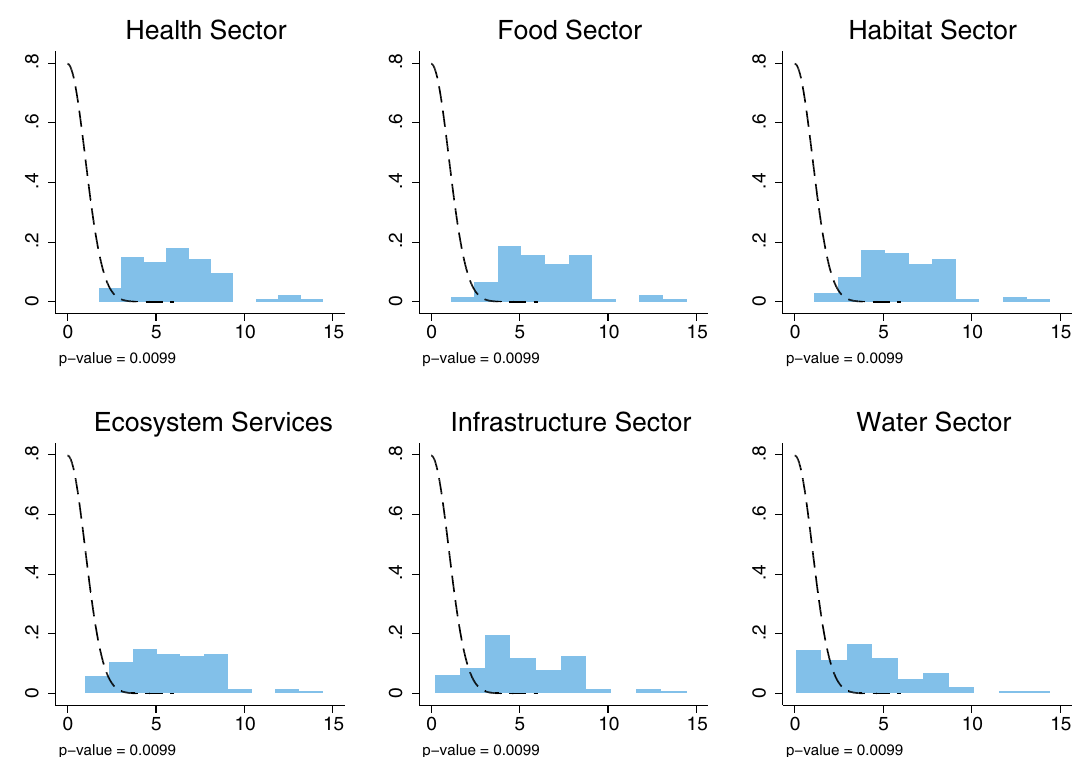
Fig. 5 Model validation of estimated parameters. Multiple-hypotheses testing of sectoral vulnerability vs. economic readiness using Romano – Wolf p - value.